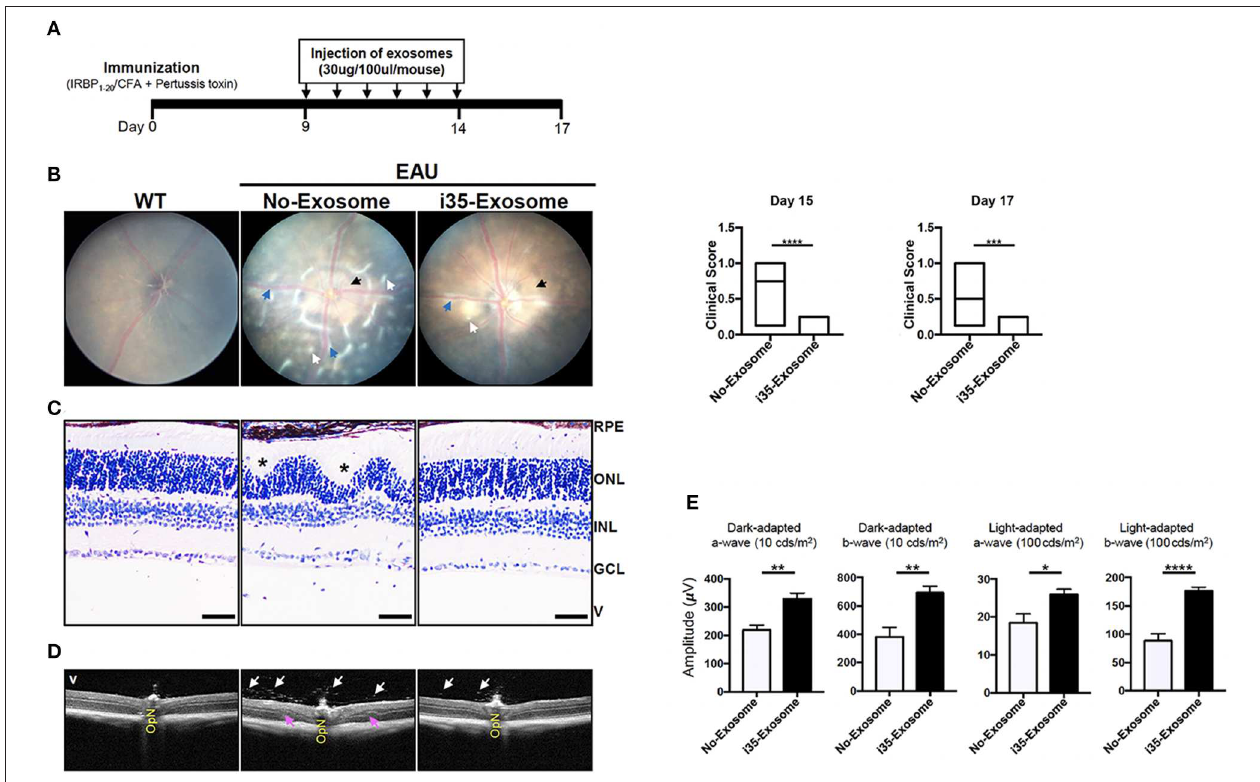
FIGURE 2 | Mice treated with i35-Exosomes are protected from developing severe EAU. EAU was induced in C57BL/6J mice by immunization with the uveitogenic peptide, IRBP 651 − 670 in CFA and effect of treatment with PBS or i35-Exosomes on EAU progression was assessed by fundoscopy, histology, optical coherence tomography (OCT), and electroretinography (ERG). (A) Scheme used for exosome treatment. (B) Fundus image of the retina was taken at day 15 or 17 after EAU induction using an otoendoscopic imaging system. Compared to mice treated with i35-Exosomes, fundus images of mice treated with PBS revealed more severe ocular inflammation characterized by significant blurring of the optic disc margins and enlarged juxtapupillary area (black arrow), retinal vasculitis (blue arrows), yellow-whitish retinal and choroidal infiltrates (white arrow). Clinical scores and assessment of disease severity were based on changes at the optic nerve disc or retinal vessels and retinal and choroidal infiltrates. Histogram to the right shows the clinical scores ( n = 14 ). (C) Histologic images. Eyes show very severe EAU in mice treated with PBS as characterized by the development massive retinal in-folding (*), a hallmark feature of severe uveitis. H&E histological sections: Scale bar, 100 µ m. V, vitreous; GCL, ganglion cell layer; INL, inner nuclear layer; ONL, outer nuclear layer; RPE/CH retinal pigmented epithelial and choroid. Blue arrows, lymphocytes; Asterisks, retinal-folds. (D) Representative OCT images show marked decrease of inflammatory cells (white arrows) in the vitreous and optic nerve head of mice treated with i35-Exosomes (white arrows) (E) ERG analysis of the retina on day-17 after EAU induction. The averages of light- or dark-adapted ERG a-wave or b-wave amplitudes are plotted as a function of flash luminance and values are means ± SEM. Data are presented as the mean ± SEM of at least three determinations. Results represent three independent studies. * p < 0.05, ** p < 0.01, *** p < 0.001, **** p <